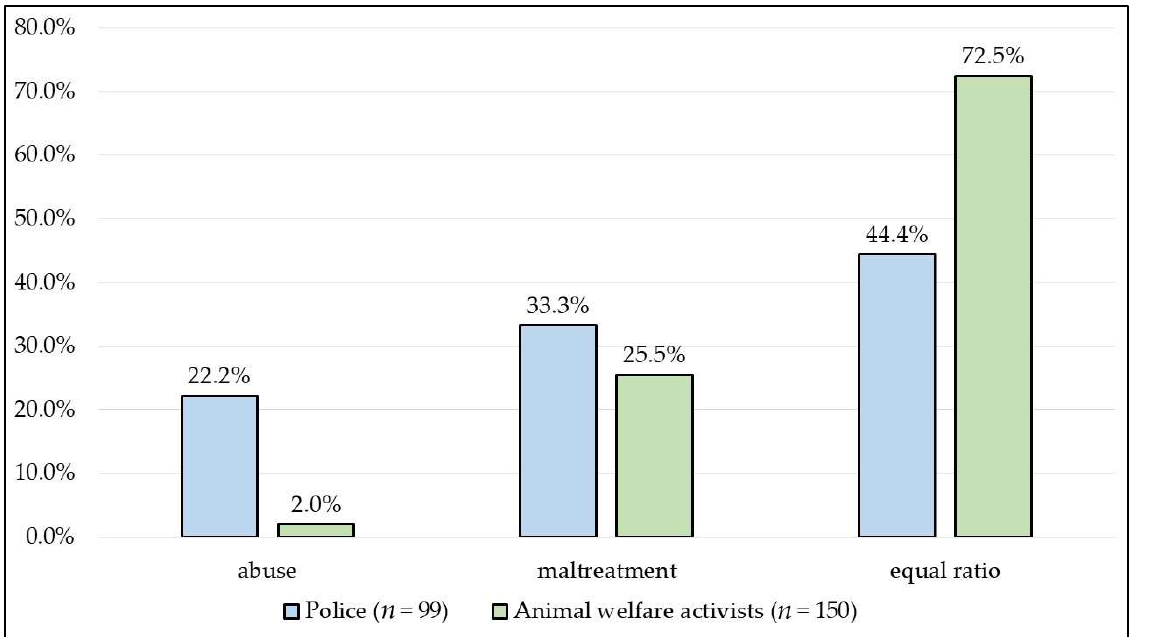
Figure 3. The probability of modus operandi according to police offices and animal welfare activists.